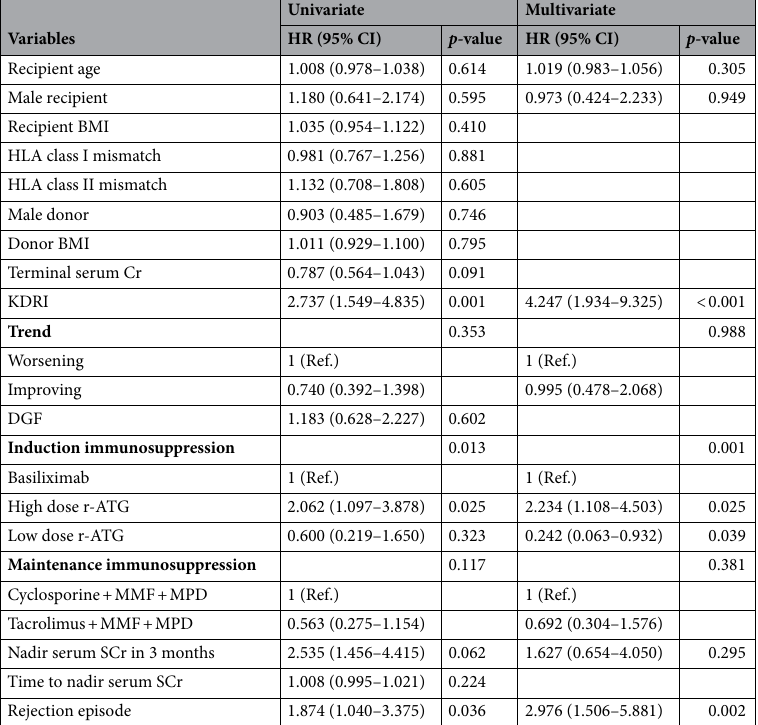
Table 5. Univariate and multivariate analyses of risk factors for graft failure in patients with AKI donors. BMI body mass index, HLA human leukocyte antigen, Cr creatinine, DGF delayed graft function, ATG anti- thymocyte globulin, MMF mycophenolate mofetil, MPD